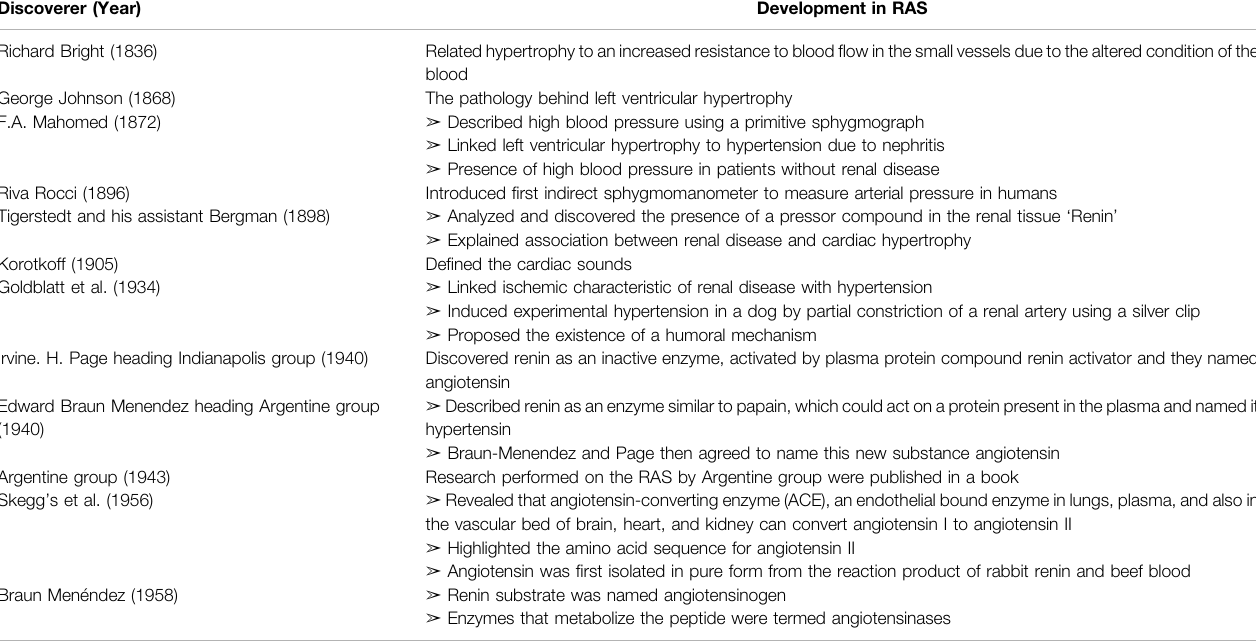
TABLE 1 | Glimpse of the historical development of